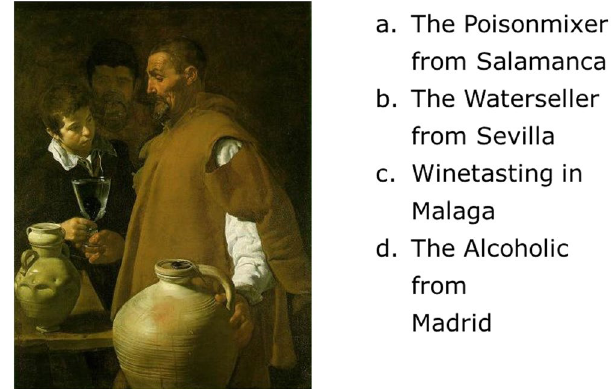
Figure 1. Exercise in D-MCT module 7 on “Jumping to Conclusions: Mind reading”. (To modify their dysfunctional thought pattern and to demonstrate that mind reading is not possible, patients are asked to guess the title of the painting and “read the mind” of the artist). The correct answer is “b” (“The Waterseller from Sevilla” by Diego Velázquez,